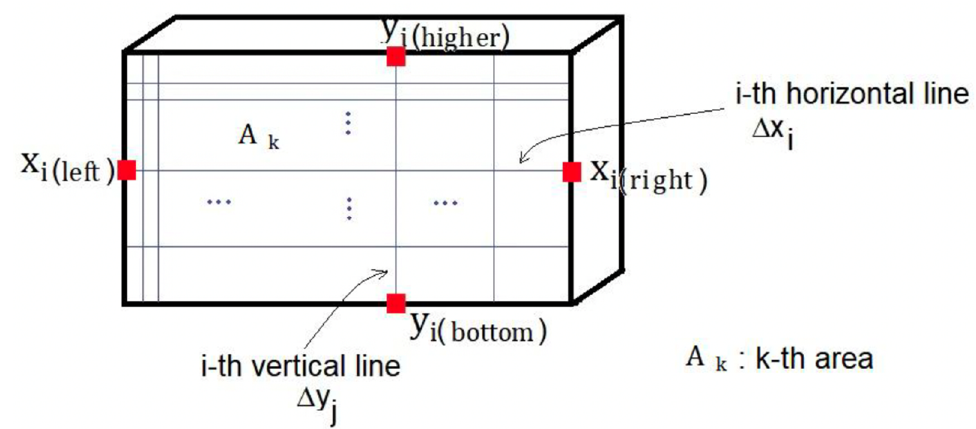
Figure 12. Model for capturing the distances of vertical and horizontal lines to obtain the average reference areas.